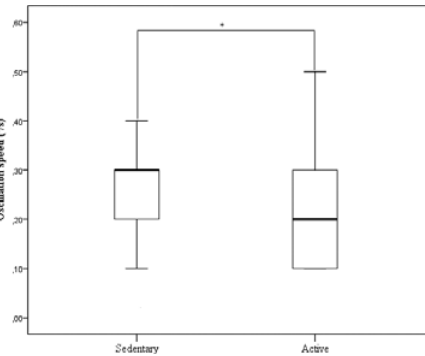
Figure 2 – Analysis of postural sway velocity in different sensory conditions (with or without visual feedback) and surfaces (firm or